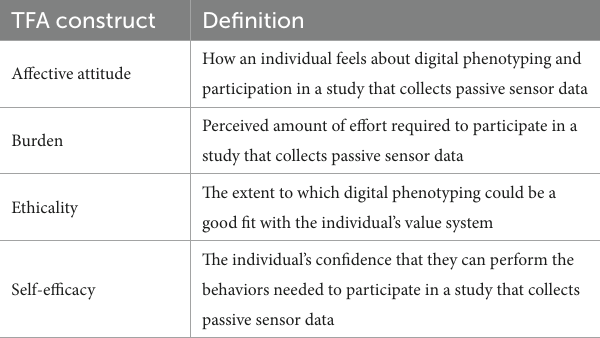
TABLE 1 Definitions of the Theoretical Framework of Acceptability (TFA) applied in this